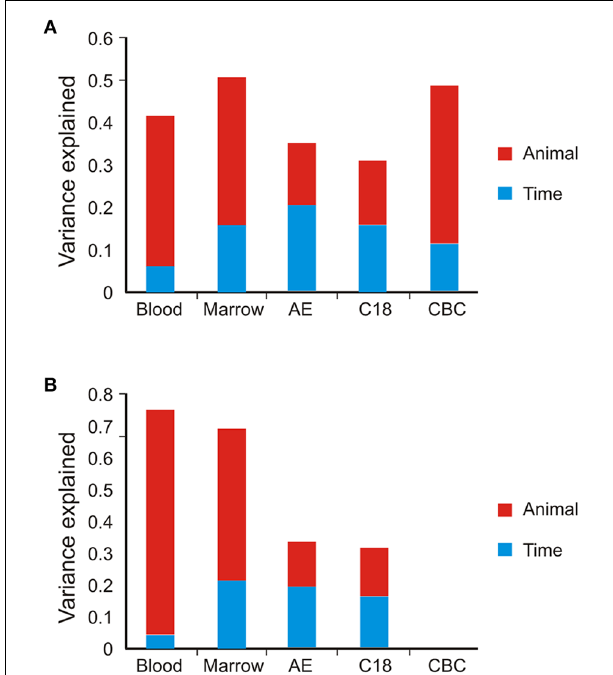
FIGURE 2 | Principal component variance component analyses. Bar graphs show the weighted average contribution of among animal (red) and among timepoint (blue) variance to gene expression, metabolite, and complete blood counts. (A) Full data set. (B) Reduced dataset after removal of low abundance transcripts or